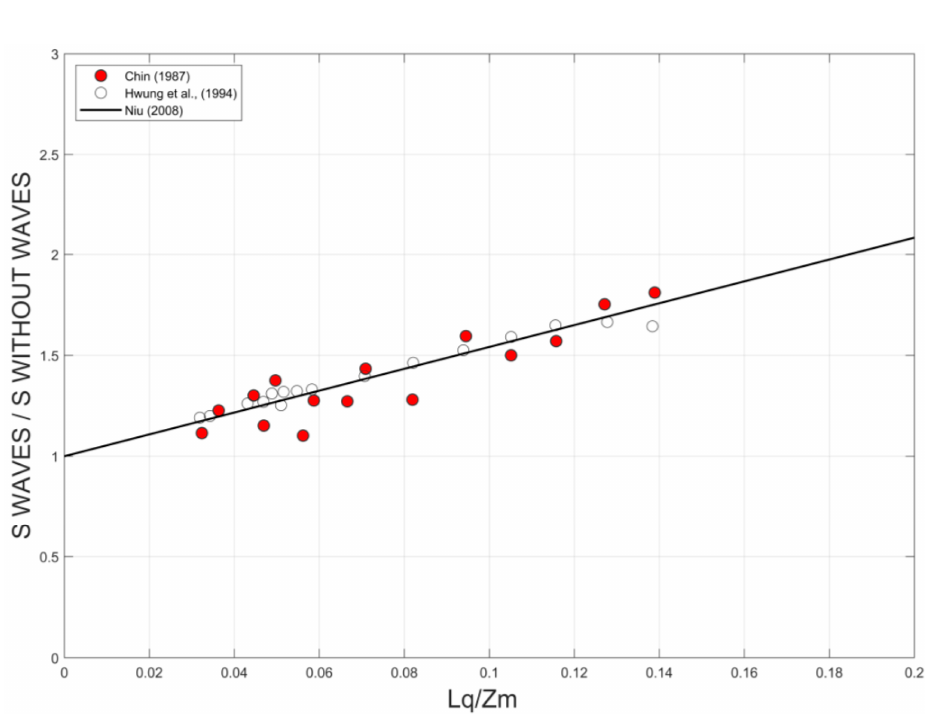
Figure 2. Validation of the equation of Niu [24] to quantify the effects of surface waves on wastewater discharge dilution (Fr = 2.658). Adapted from Niu [24].